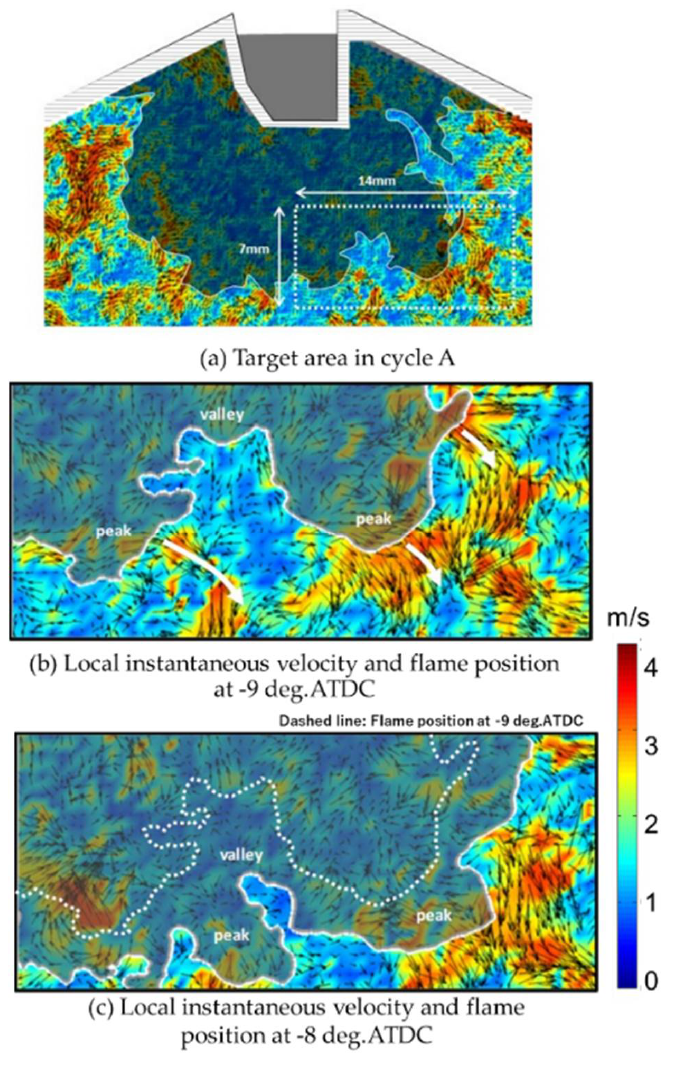
Figure 13. The interaction between in-cylinder flow and flame propagation in the cycle. ( a ) The high turbulence area is highlighted and enlarged at ( b ) − 9 deg. ATDC and ( c ) − 8 deg. ATDC. near the spark location of cycle B. In this cycle, the flame front propagates with bias under the influence of the tumble flow. Here, the target area is 7.2 mm × 13.5 mm 2 in the vicinity of the spark plug, indicated by a white dashed line in Figure 14a. The local flame shape was not smooth, and there were several small peaks and valleys. Figure 14b,c show the flame shape and velocity distribution in the target area of cycle B at − 9 and − 8 deg. BTDC, respectively. In Figure 14b, the high-frequency velocity component was strong near the local flame peak and weak near the local flame valley, as in Figure 14b. In the lower half of Figure 14c, the flame at the local peak region propagated while pulling the valley region and the local valley region disappeared. In the upper half of Figure 14c, near the spark plug, the flame surface was pushed back to the unburned portion under the influence of the flow opposite to the propagation direction. The turbulence level of the unburned area is enhanced in these existing bulk flow streams as the flame propagates through them. Small scale eddies have a strong effect on flame curvatures and are wrinkleless, which can also help to push the flame propagation through difficult bulk-flow